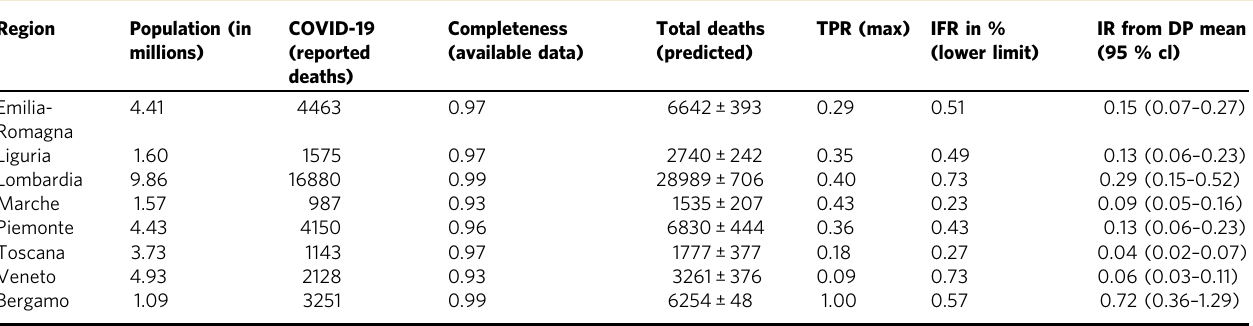
Table 1 Estimated fatalities, infection rates (IR), and infection fatality rates